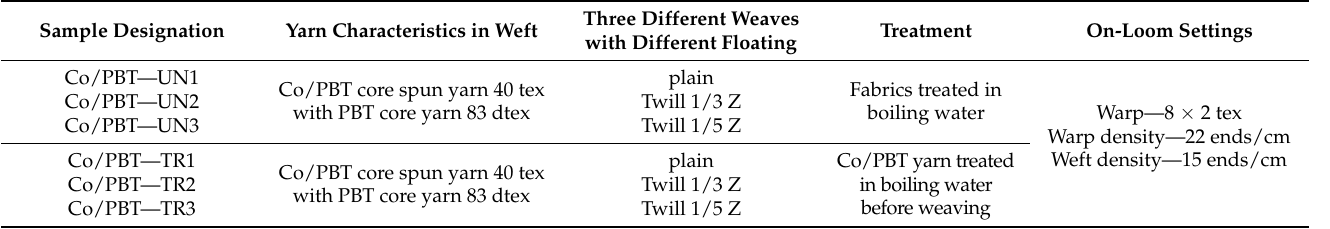
Table A8. Designation of the samples.